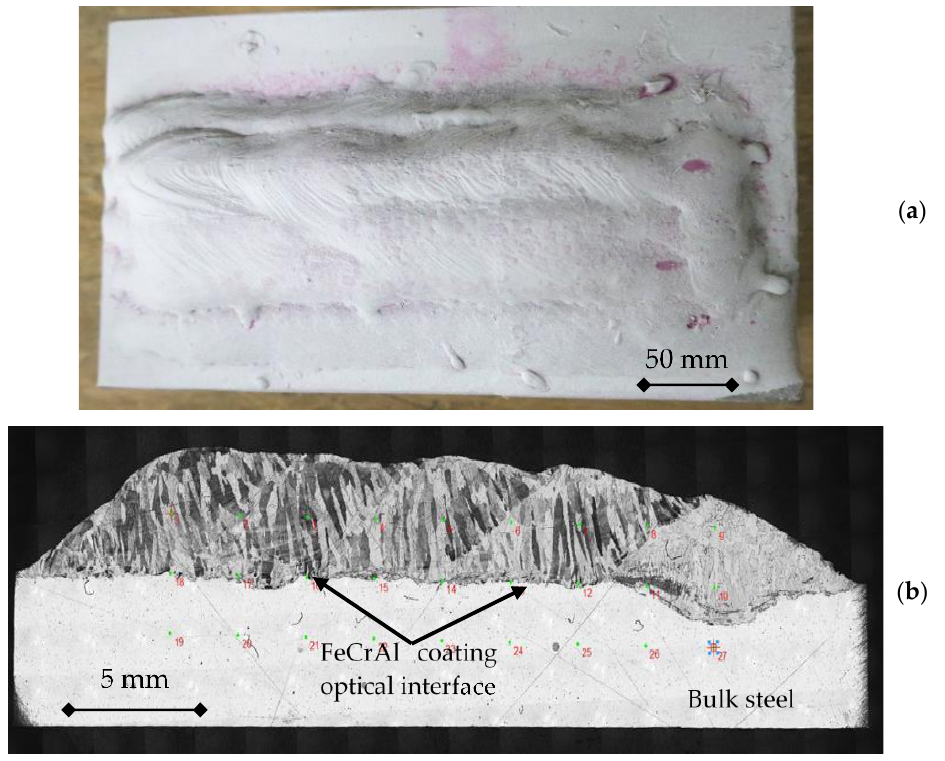
Figure 6. The 800H steel coating ( a ) and a metallographic section of bulk and coating ( b ). Table 4. Main deposition parameters.